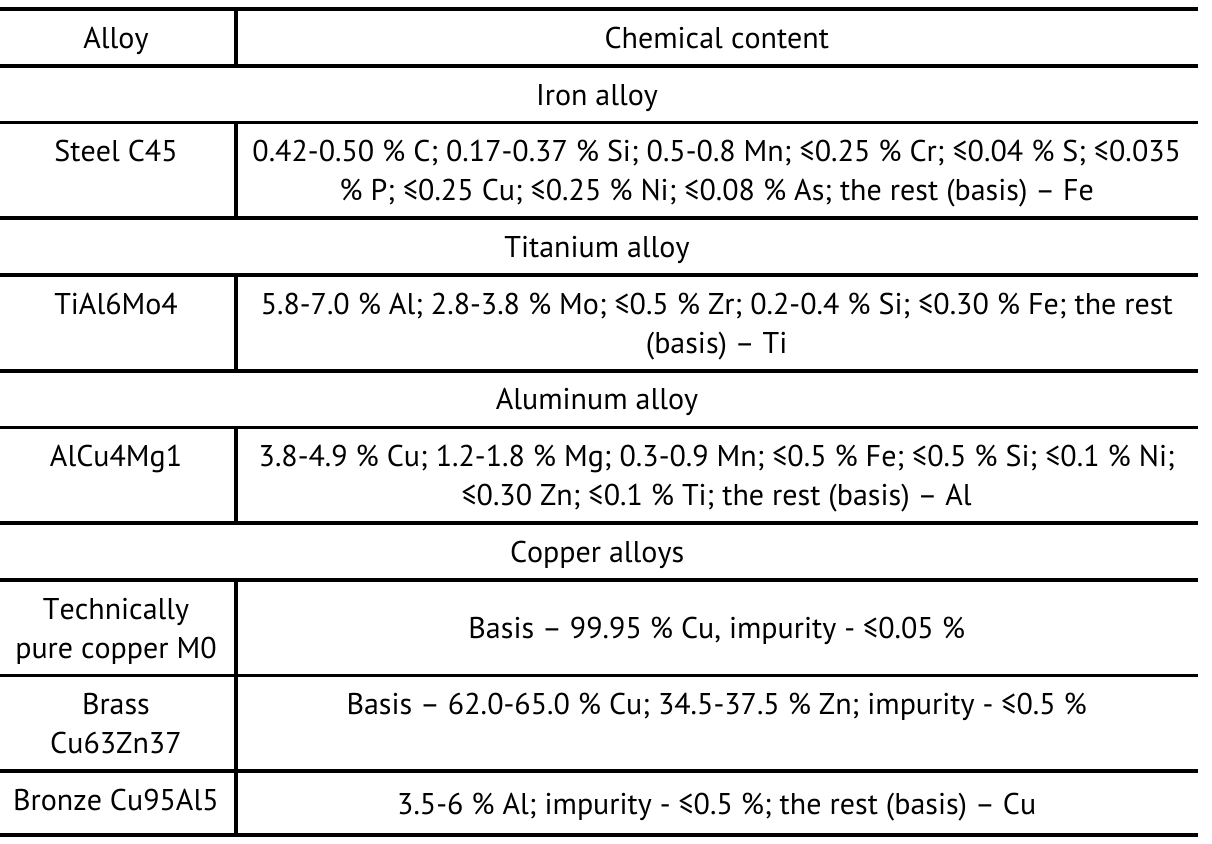
Chemical content of machined pieces